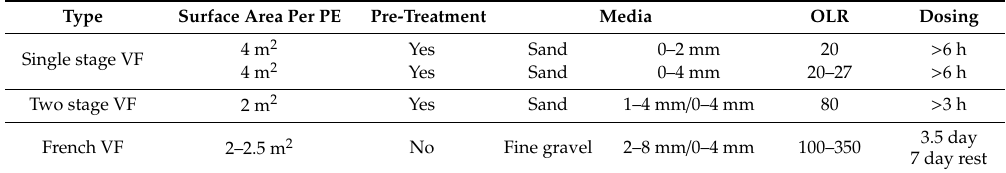
Table 1. Comparison of design parameters of VF wetland types to prevent clogging (adapted from